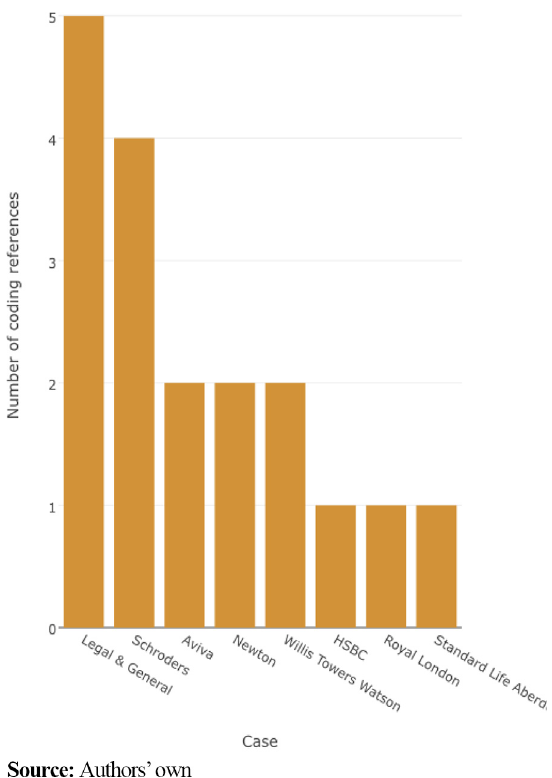
Figure 6. Number of climate risk pricing techniques taken per